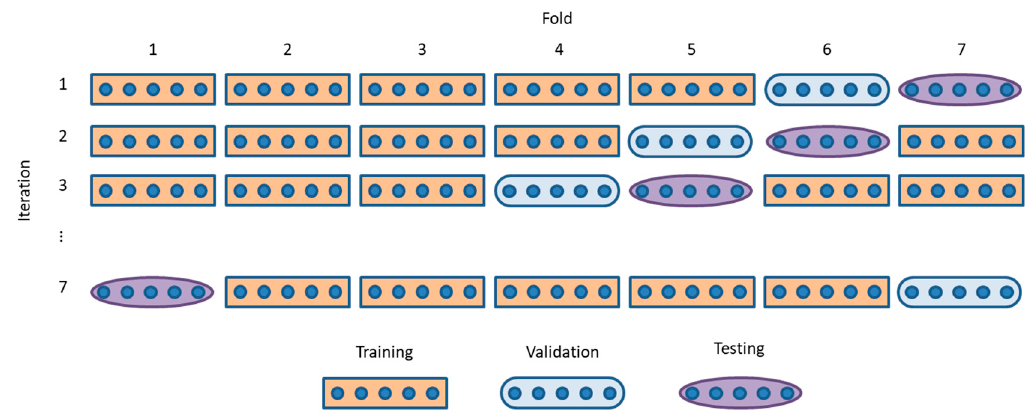
Figure 2. Cross-validation technique.